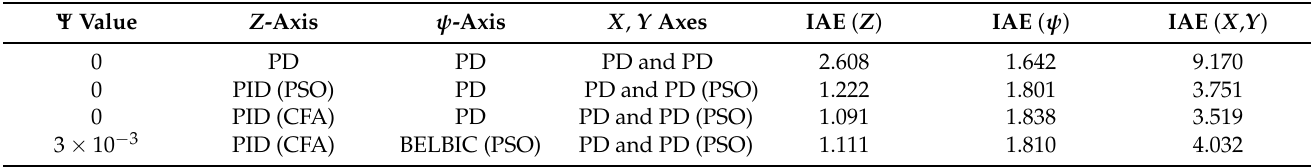
Table 6. Results obtained for the square-shaped flight profile with different position controllers in a time horizon of 10